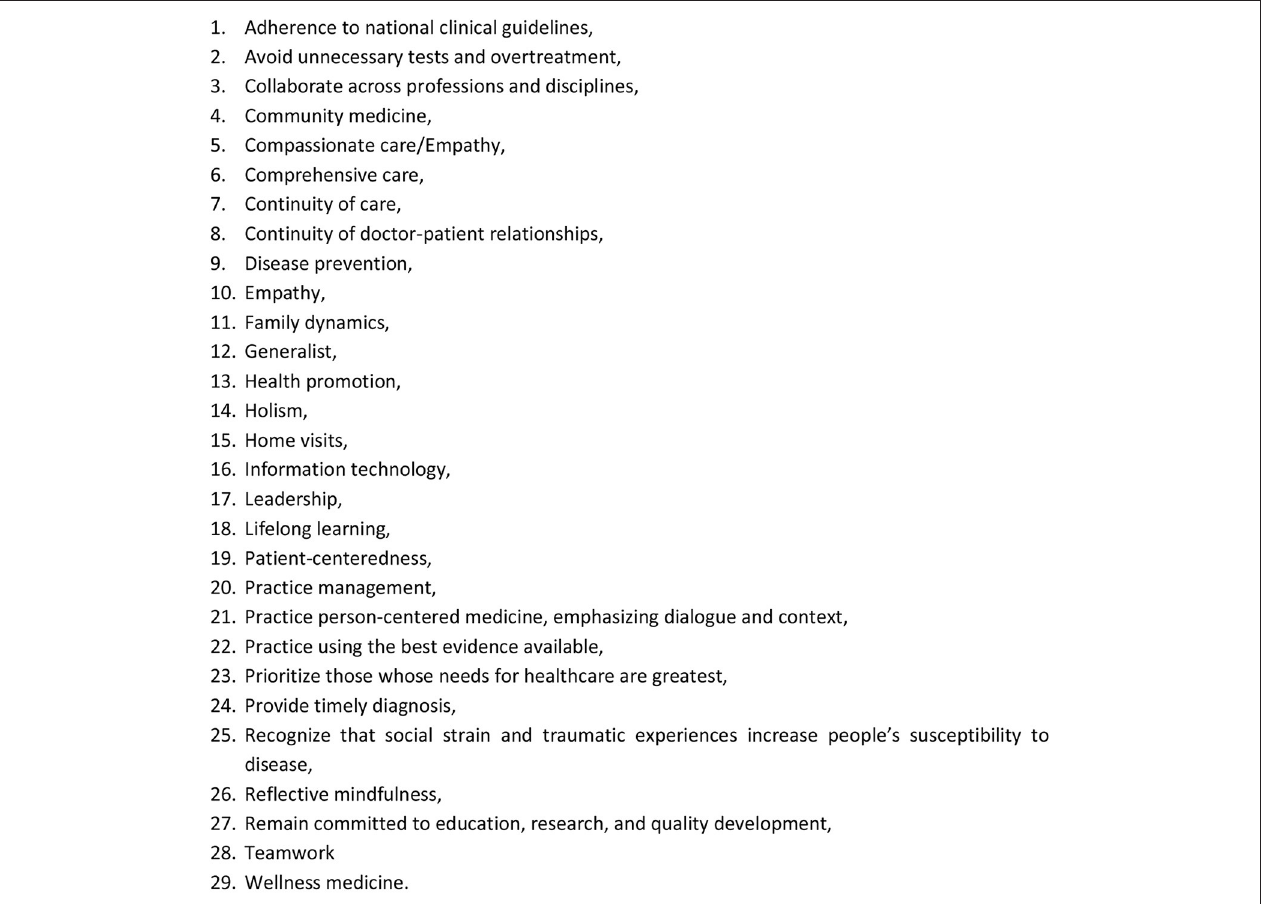
FIGURE 1 | Checklist of Collated Core